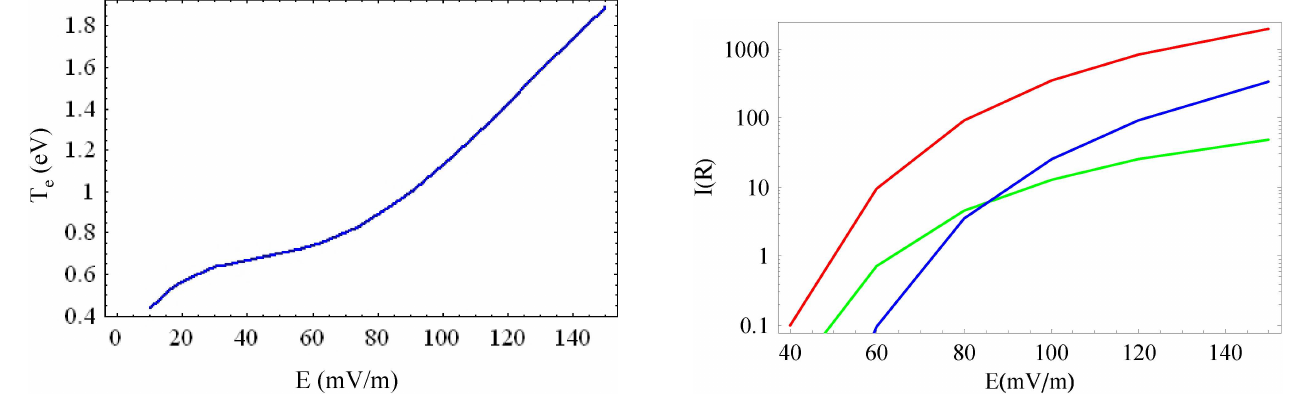
Fig. 4. Electron temperature (left panel) and luminous flux versus parallel electric field (right panel). The green trace corresponds to the oxygen green-line emission; the red trace corresponds to N 2 (1P); and the blue trace corresponds to N 2 (2P) band emission.